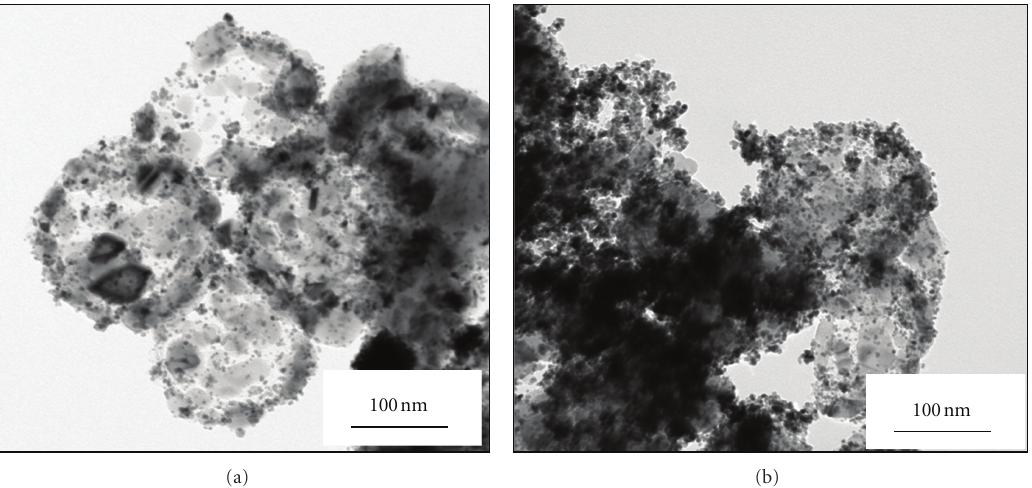
Figure 3: TEM images of Pt nanoparticles deposited on hollow Nb-TiO 2 nanosphere supports with di ff erent Pt loadings. (a) 10 wt% and (b) 40